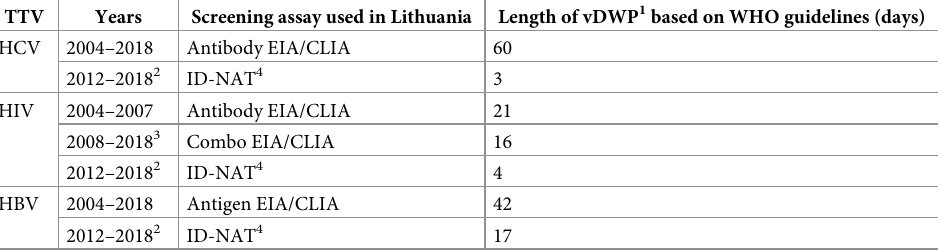
Table 1. Length of vDWP for different TTV screening assays used at the National Blood Center of Lithuania. TTV Years Screening assay used in Lithuania Length of vDWP 1 based on WHO guidelines